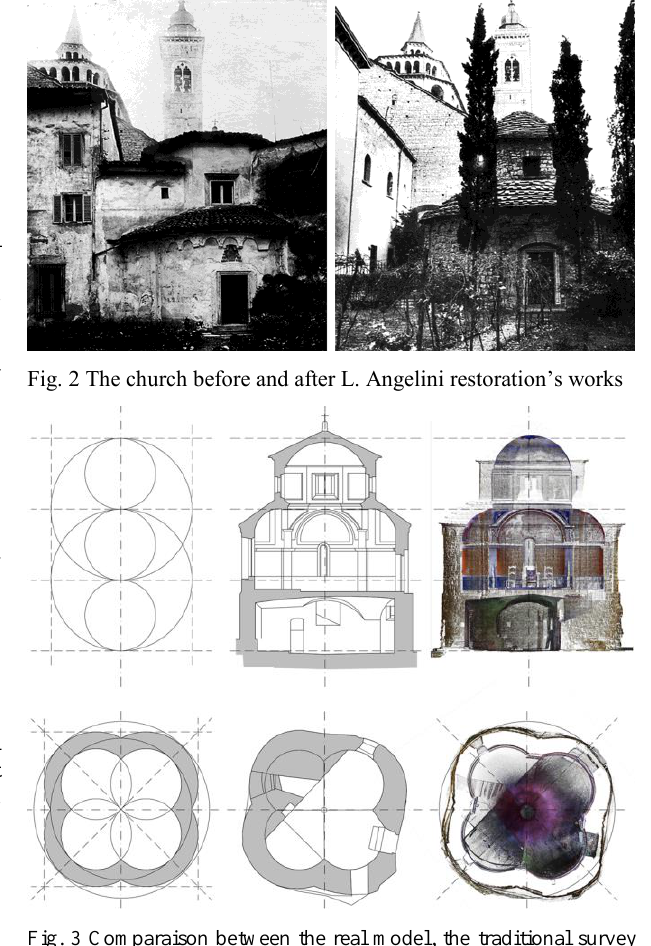
Fig. 3 Comparaison between the real model, the traditional survey and laser scanning